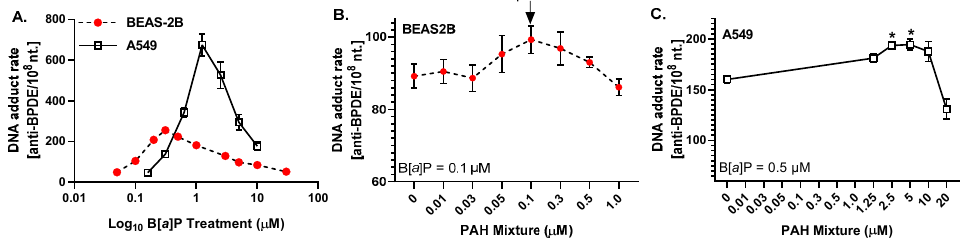
Figure 2. Formation of anti -BPDE DNA adducts in response to B[ a ]P in BEAS-2B and A549 cells ( A ), and to B[ a ]P in combination with increasing doses of LMW PAHs in BEAS-2B ( B ) and A549 cells ( C ). The data show mean ± SEM (n = 3); * p < 0.05 for 0.5 μ M B[ a ]P combined with 2.5 or 5 μ M LMW PAHs compared to B[ a ]P alone.